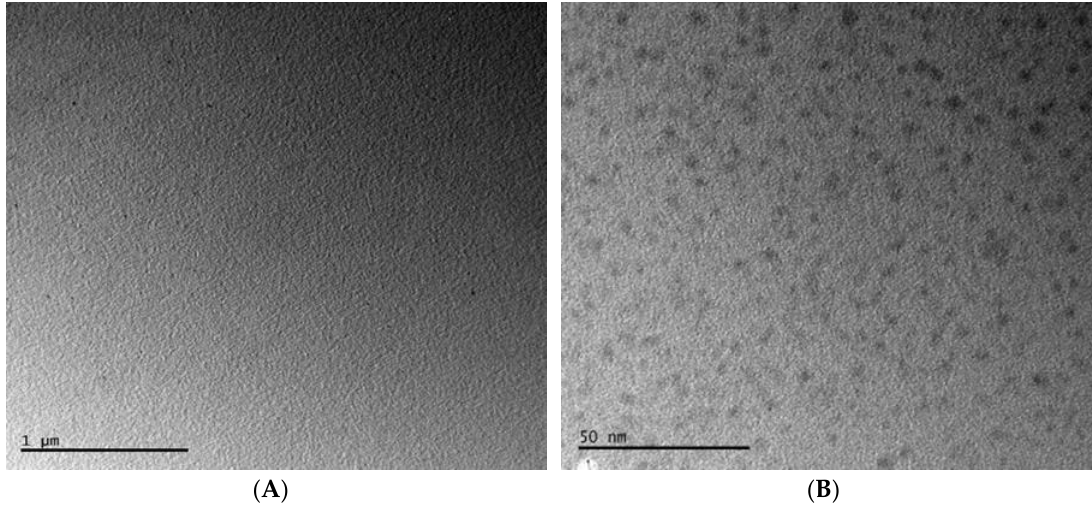
Figure 3. Characterization of GQDs using TEM at 1 µ m ( A ) and 50 nm ( B )